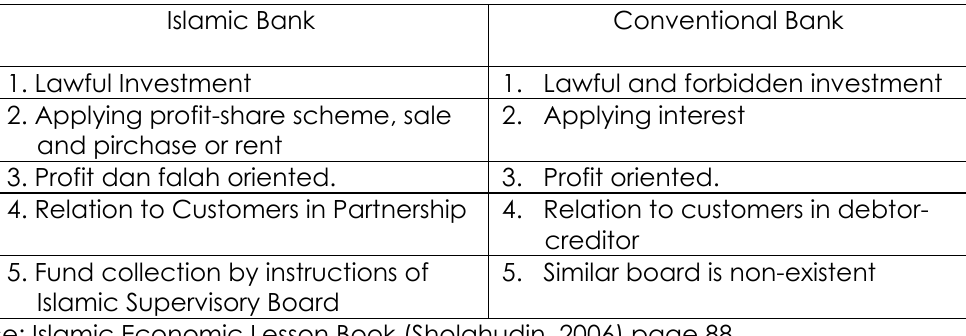
Table 1. Difference of Islamic Bank from Conventional